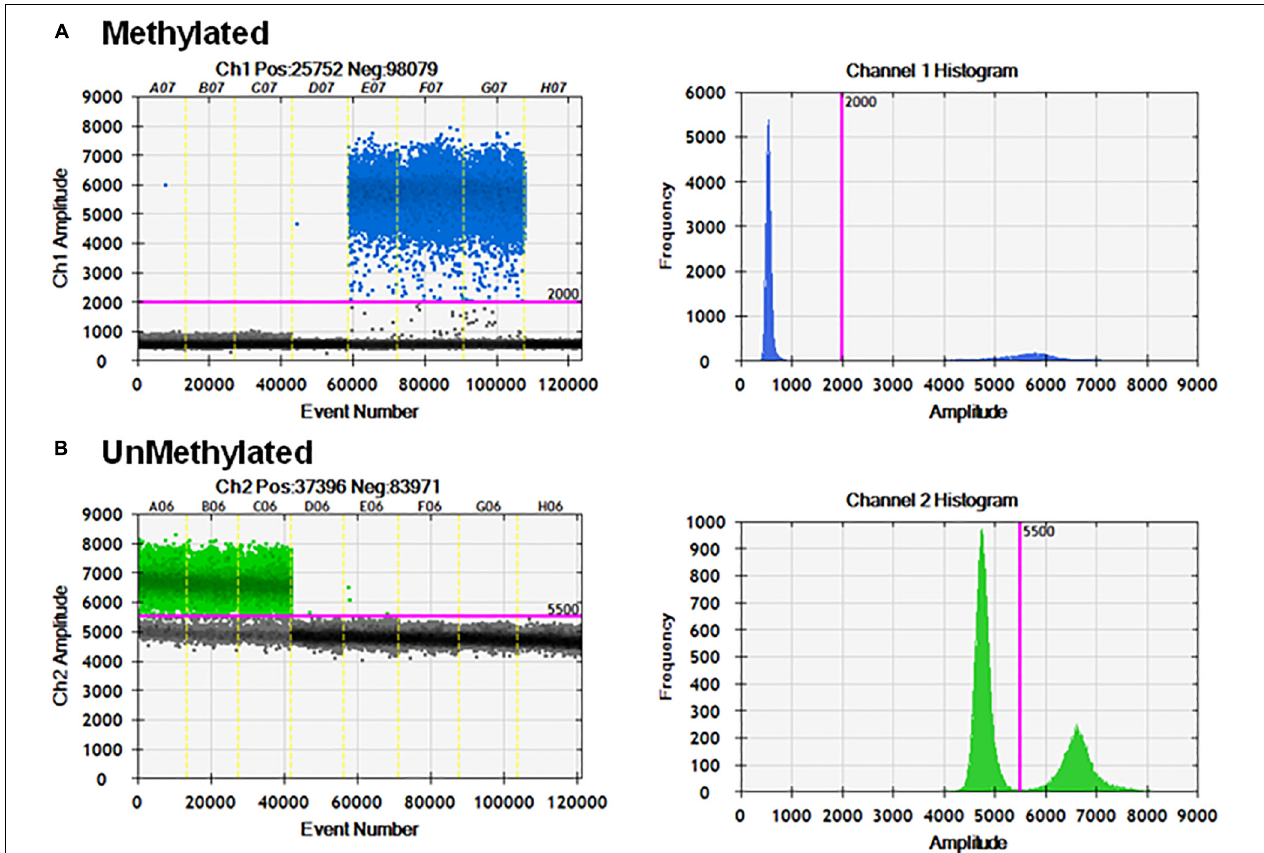
FIGURE 3 | Specificity of ddMSP assay. ddPCR in the presence of mixtures of methylated and unmethylated plasmids. (A) Methylation probe and primers can only detect methylated CpGs and cannot detect unmethylated CpGs. (B) Unmethylation probe and primers can only detect unmethylated CpGs and cannot detect methylated